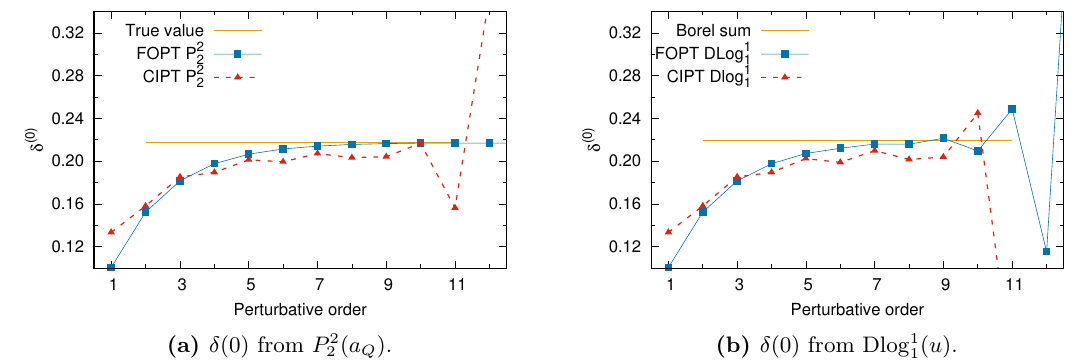
Figure 7. Perturbative expansion of (cid:14) (0) in FOPT and CIPT obtained from (a) P 2 of table 2) and (b) Dlog 1 ( u ) (5th row of table 1